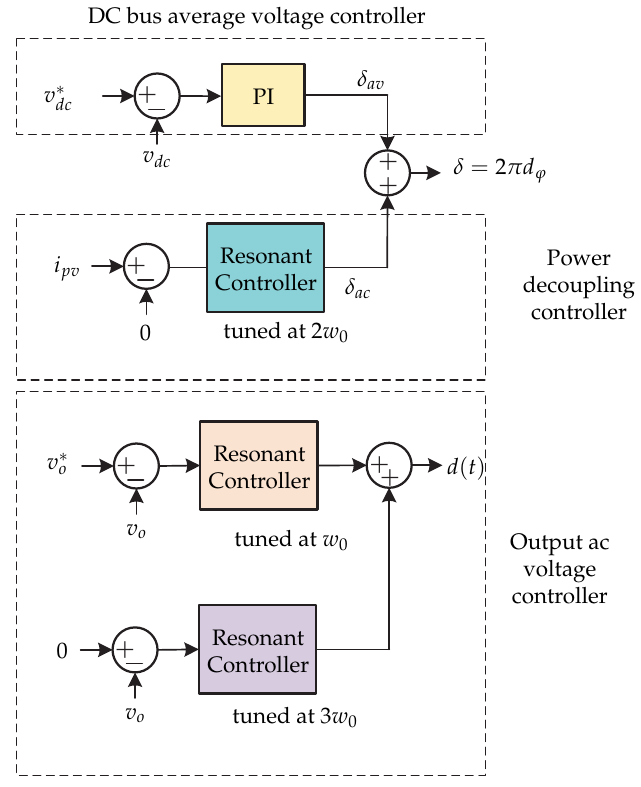
Figure 23. Control strategy proposed in [62].